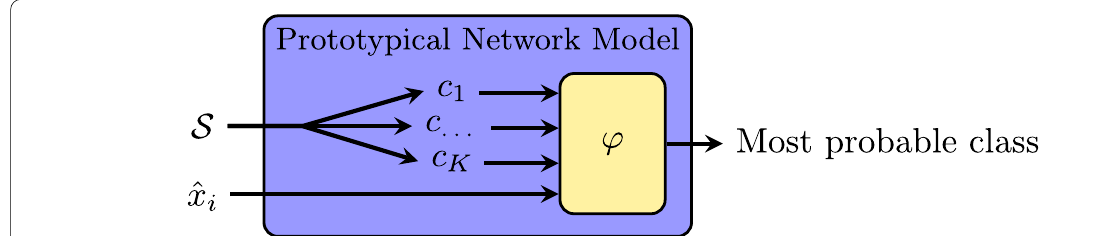
Fig. 4 Illustration of the prototypical network model to predict class of a new example ˆ x i